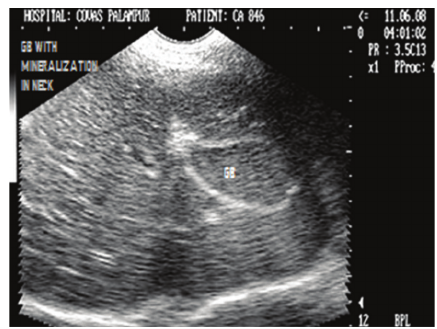
Figure 28: Right lateral radiograph of a nine-year-old spayed female, German shepherd dog revealing hepatic nodular masses on the caudal visceral margins of right liver lobes irregular. Visualization was enhanced by the negative contrast provided by air in gastric